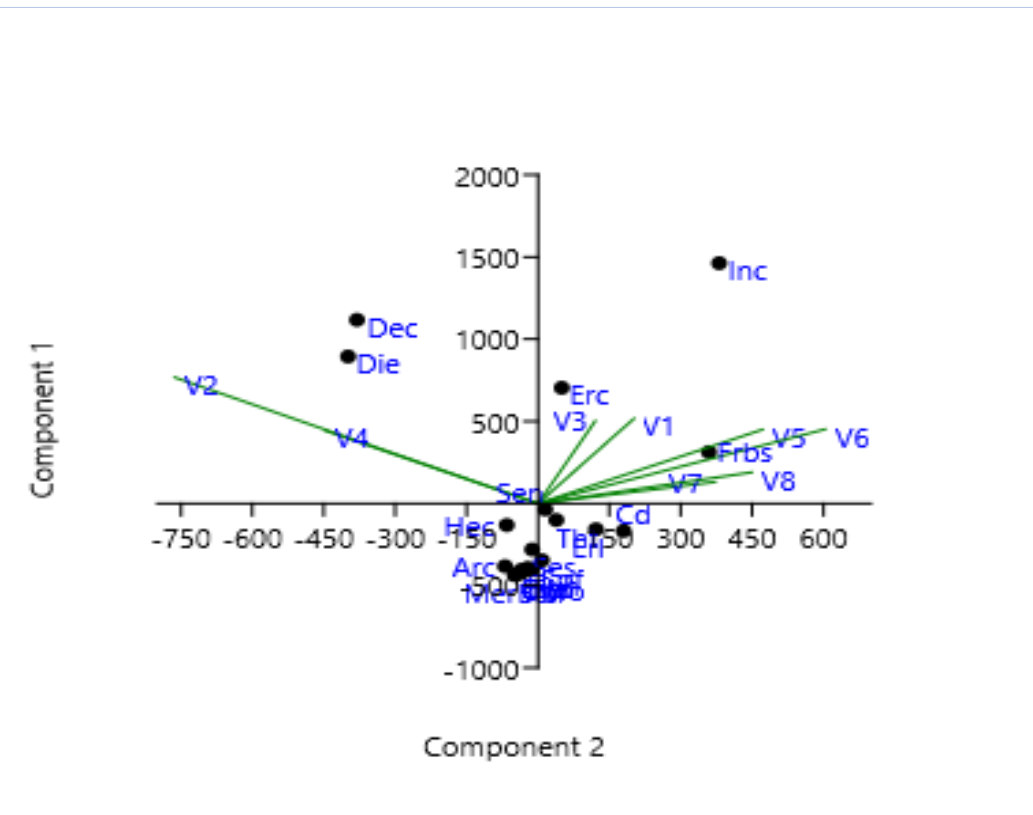
Figure 7. Principal component analysis (PCA) plot showing the effect of resting period and rainfall reduction on overall biomass yield (kg.ha − 1 ) and other vegetation parameters in 2016/17. Key to symbols: Black dots ( ● ) indicate treatment and the season and vectors ( ) indicate the direction of the relationship between vegetation parameters and treatments. The longer the vector radiating from the centre, the stronger the effects of the resting period and the resting period and the closer the dot to the vector the stronger the relationship between species and soil property. V 1 = 0% RD, 70 RP, V 2 = 0% RD, 90 RP, V 3 = 15% RD, 70 RP, V 4 = 15% RD, 90 RP, V 5 = 30% RD, 70 RP, V 6 = 30% RD, 90 RP, V 7 = 60% RD, 70 RP, V 8 = 60% RD, 90 RP. Cd = Cynodon dactylon, Die = Digitaria eriantha, Erc = Eragrostis curvula, Tht = Themeda triandra, Erl = Eragrostis lehmaniana, Spf = Sporobolus fimbriatus, Hec = Heteropogon contortus, Sen = Setaria nigrirostris, Ses = Setaria sphacelata, Cye = Cymbopogon excavatus, Umos = Urochloa mosambicensis, Erb = Eragrostis barbinodes, Arc = Aristida congesta, Erpl = Eragrostis plana, Brs = Brachiaria serata, Hyh = Hypperhenia hirta, Mer = Melinis repens Frbs = Forbs, Dec = Decreasers, Inc = Increasers.